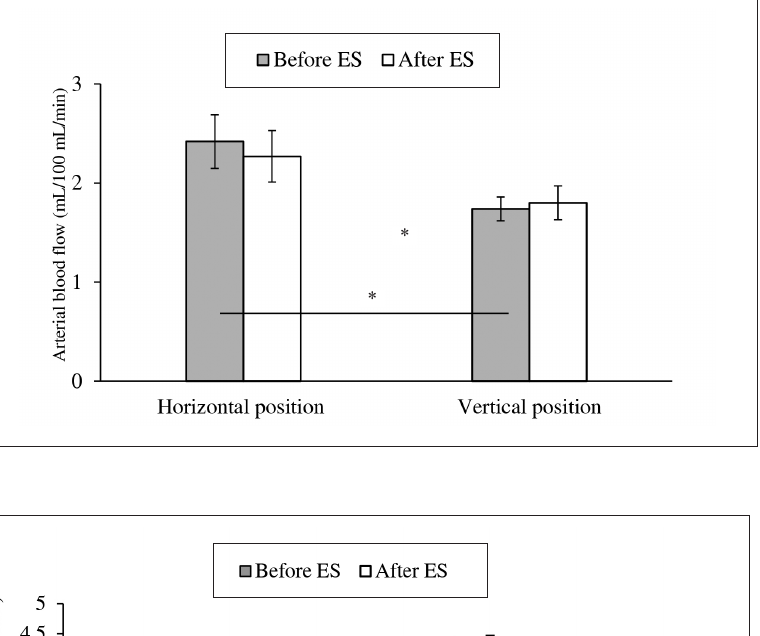
Figure 2. Change in venous